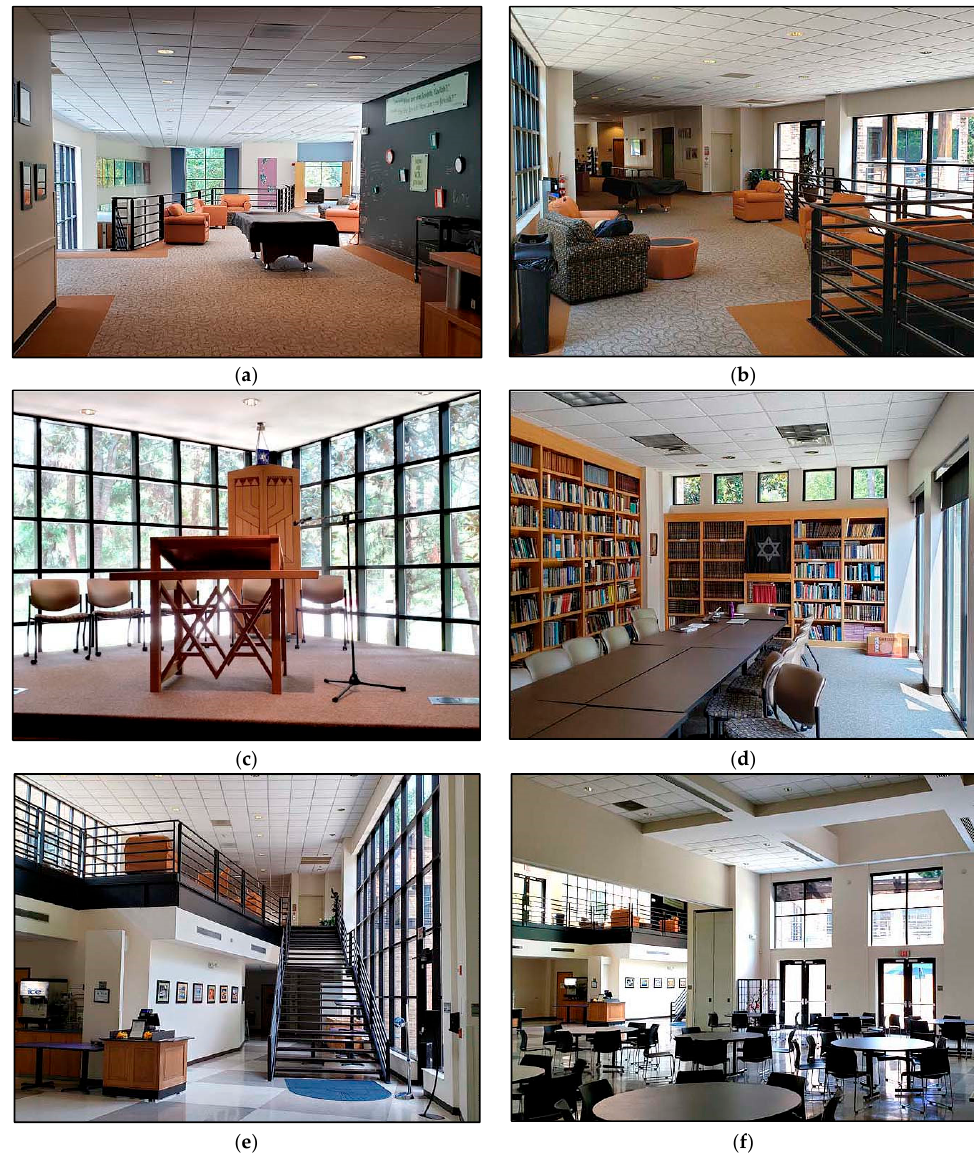
Figure 14. Freeman Center for Jewish Life at Duke, interior views. ( a ) View from reception (upper level); ( b ) lounge area (upper level); ( c ) sanctuary facing bemah (upper level); ( d ) library (upper level); ( e ) central space and stairs (upper level); ( f ) commons and dining (upper level). Image Credits: © 2019 Jeremy Kargon.